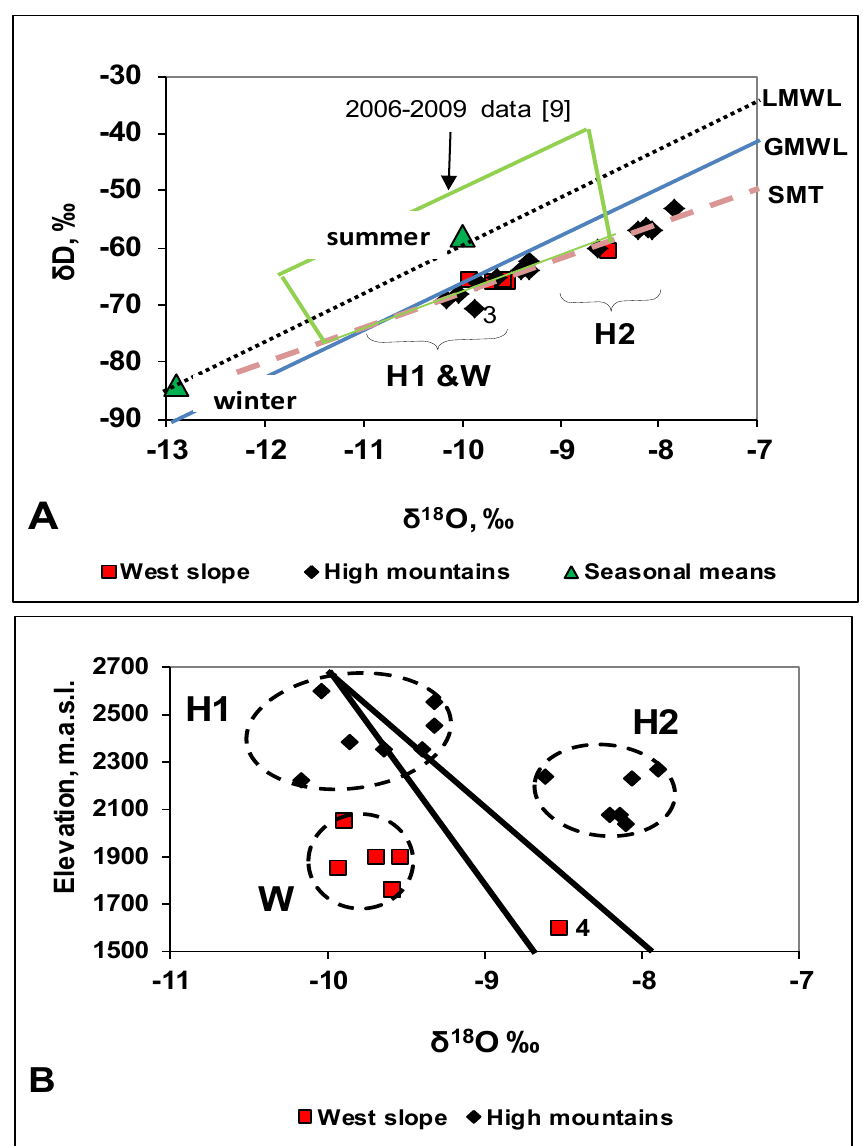
Figure 4. ( A ) Plot of δ 18 O vs. δD for groundwater samples from the high Sacramento Mountains. The green line encloses groundwater isotope data from [9]. Seasonal means for precipitation and the local meteoric water line (LMWL) are for years 2006–2009 [9]. Data plotted as individual points were collected for this study in 2003; ( B ) Plot of elevation of well collars vs. δ 18 O for sample sites in the high Sacramento Mountains. The diagonal lines show the long-term δ 18 O lapse-rates of −1.2‰/1000 m (Tucson Basin [21], and 1.8‰/1000 m [13]. Site numbers (e.g., 3) correspond to entries in Table 1, where the corresponding number is